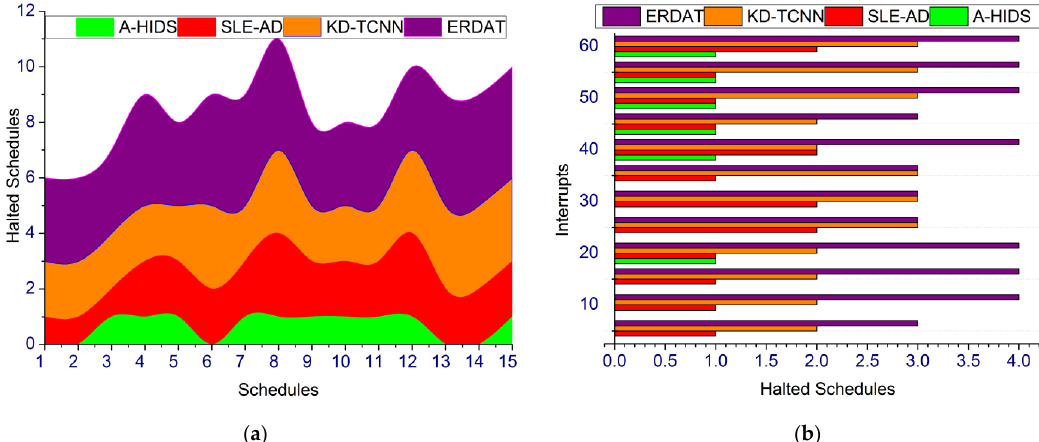
Figure 11. Halted Schedules. ( a ) Halted Schedules. ( b ) Iterupts.